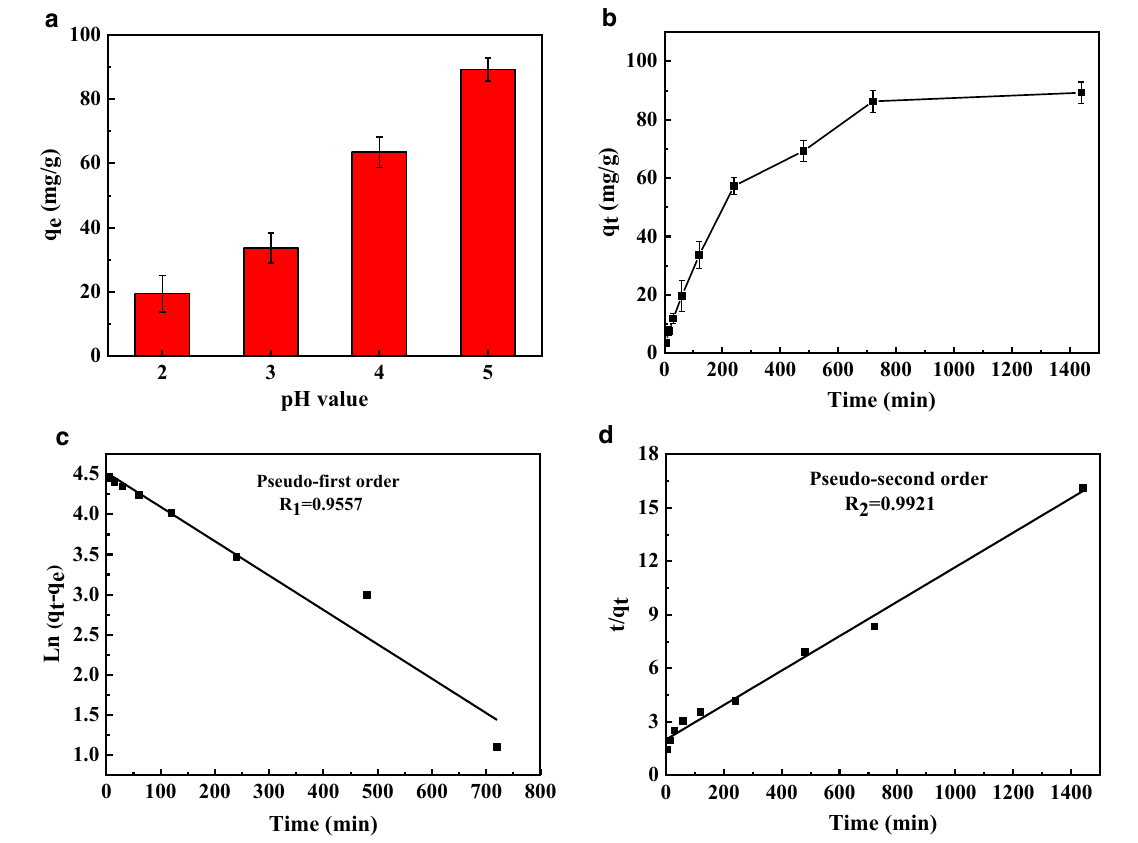
Fig. 9 a The effect of pH on the Pb2 + adsorption capacity, b the effect of the contact time on the adsorption of Pb2 + and ( c 1-2) the adsorption kinetic modeling using a pseudo first-order and pseudo second-order models